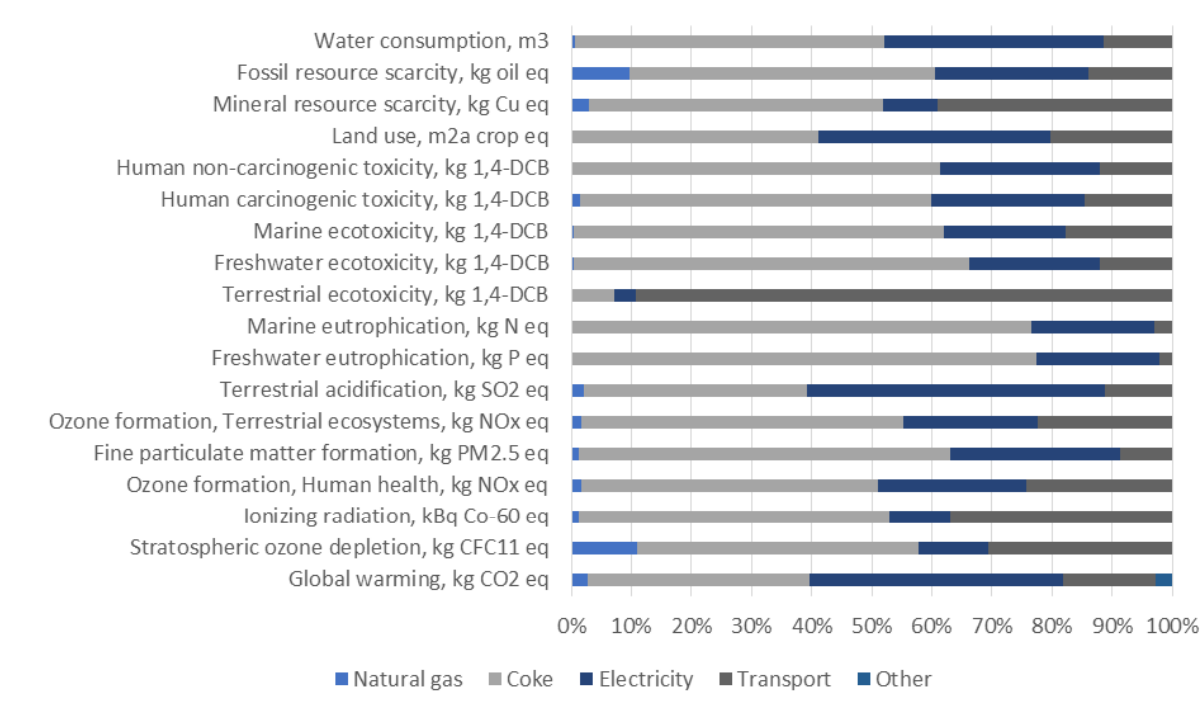
Figure 4. The contribution of various combined processes in total impact scores was obtained for 18 different impact categories for scenario 2 (black mass excluded).